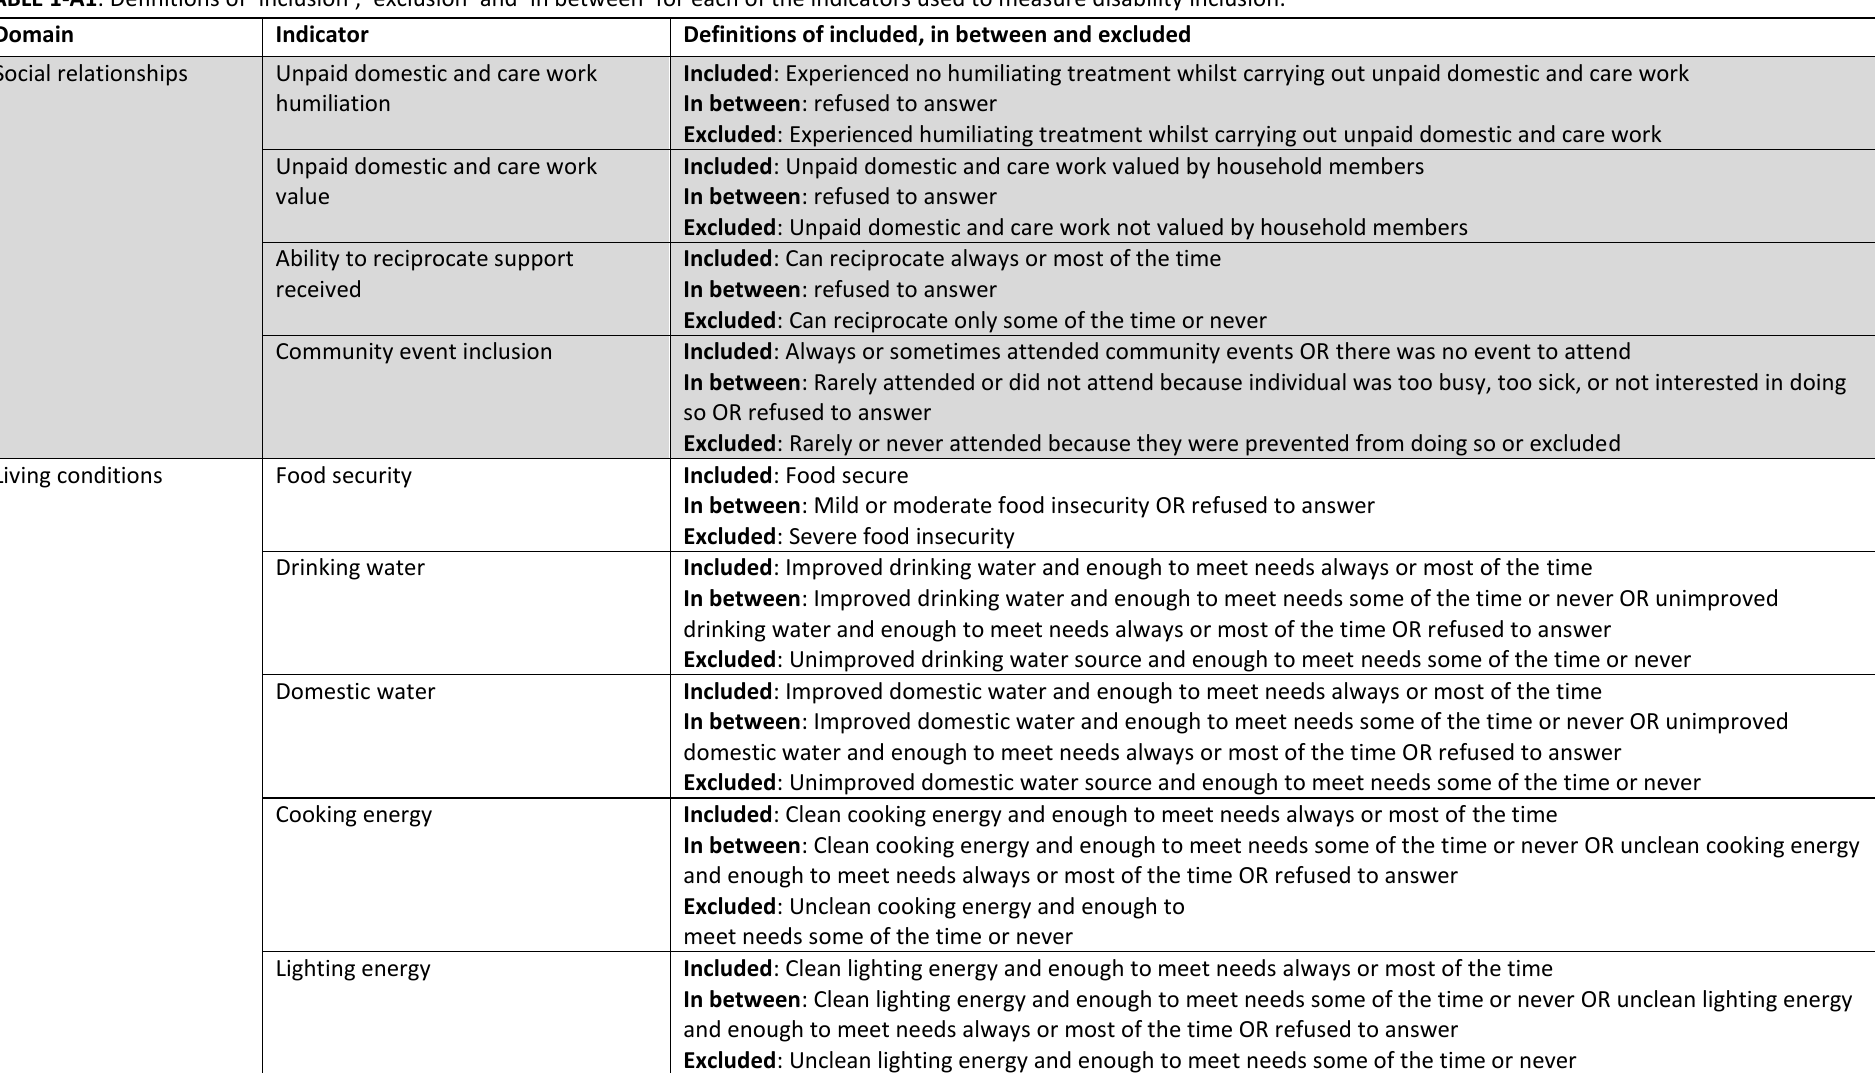
TABLE 1-A1 : Definitions of ‘ i nclusion’, ‘ e xclusion’ and ‘ i n between’ for each of the indicators used to measure disability inclusion. Domain Social